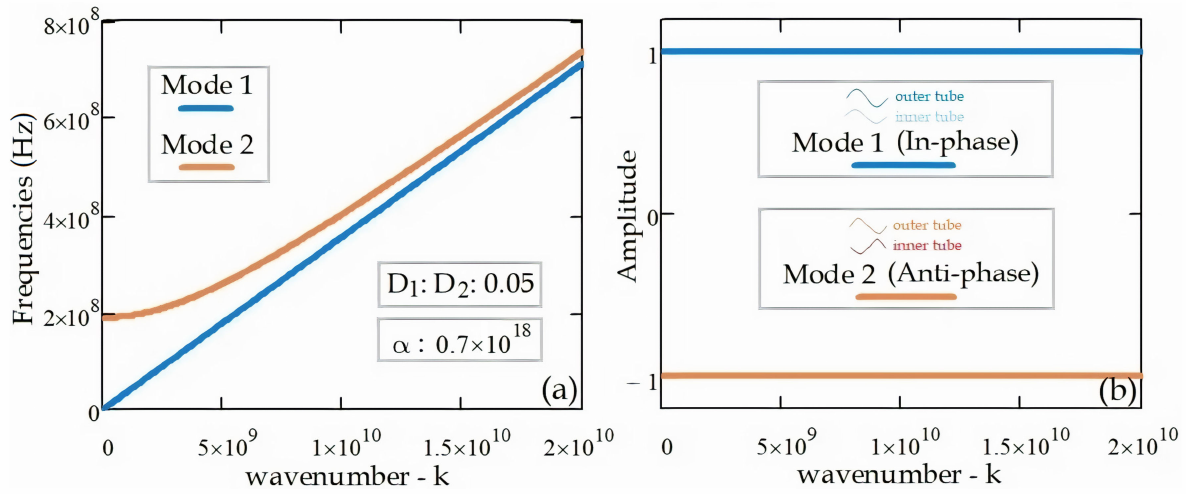
Figure 4. ( a ) EM wave dispersion relation (k, ω ), ( b ) EM wave amplitudes in the DWT. Using D = 1/( µε ) and the permeability and permittivity values from [17], the material parameter, D , is obtained as 0.05 approximately. The behaviors of electromagnetic wave propagation in the DWT having a material parameter of D 1 for the inner tube and D 2 for the outer tube can be seen from Figure